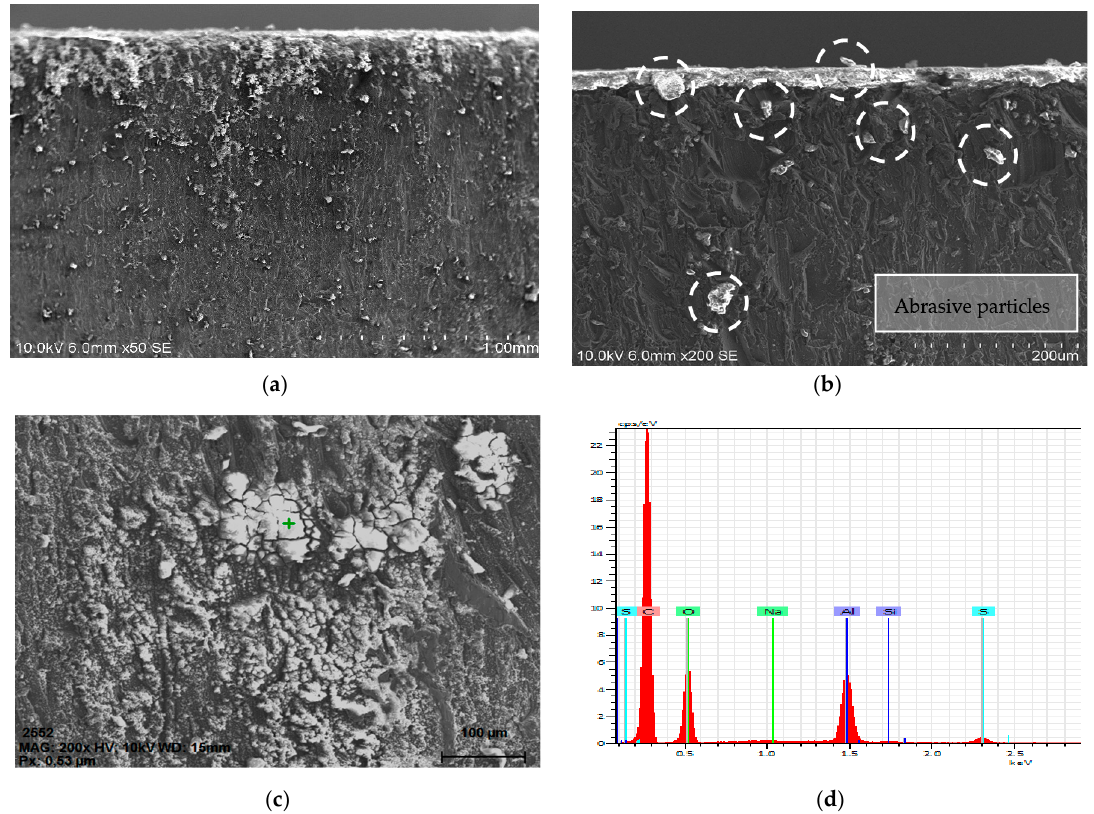
Figure 9. Test 2 Scanning Electron Microscopy (SEM) evaluation: ( a ) Abrasive imbued into UNS A97075; ( b ) abrasive particles in the interface and channel created over the material; ( c ) remains of carbon and point of EDS; ( d ) EDS results with a peak on the carbon.